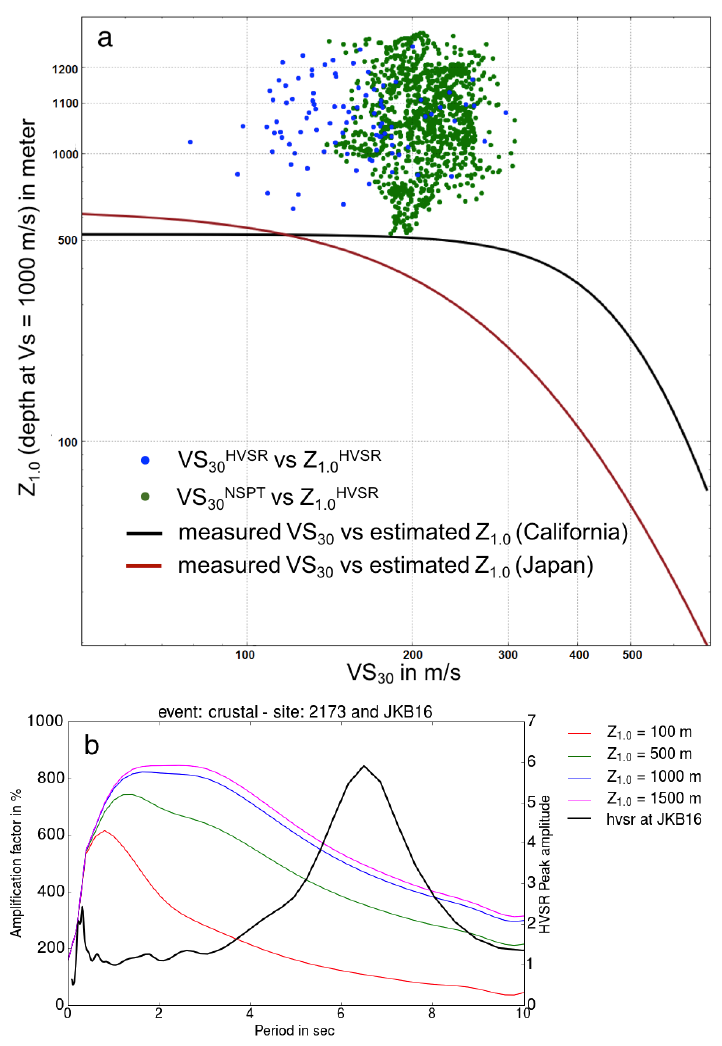
Figure 5. The behaviour of the deep sediment terms in the CY2014 GMPE compared with parameters for the Jakarta Basin. ( a ) Plot of V S 30 against Z 1.0 and curves showing estimated Z 1.0 as a function of measured and computed V S 30 derived by Chiou & Youngs [8] from data taken in California (black line) and Japan (brown line). The blue and green dots are plots of Z 1.0 from the Cipta et al. [13] model for the Jakarta Basin plotted against V S 30 taken from the same model and from the NSPT data of Ridwan [36], respectively. ( b ) Amplification of pseudo-spectral acceleration as a function of period calculated for different values of Z 1.0 , compared with a typical HVSR curve for the Jakarta Basin measured by Cipta et al. [13]. Locations of S2176 and JKB16 are showing in Figure